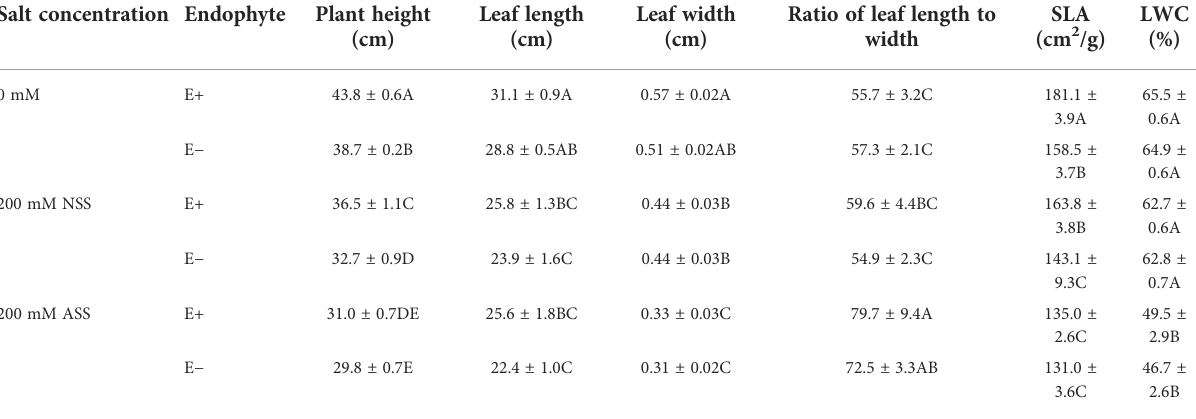
TABLE 2 The effect of endophyte status on the vegetative growth of L. chinensis in the same concentration (200 mM) of NSS and ASS